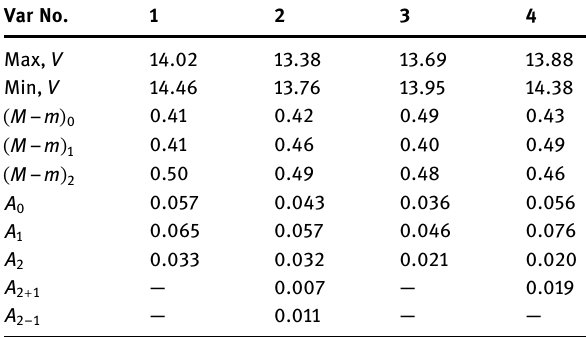
curves: magnitudes at maximum and minimum, asym - metry parameter M m – , and semi - amplitudes of the indi - vidual oscillation modes ( A 0 , A 1 , and A 2 respectively ) and the detected interaction modes (